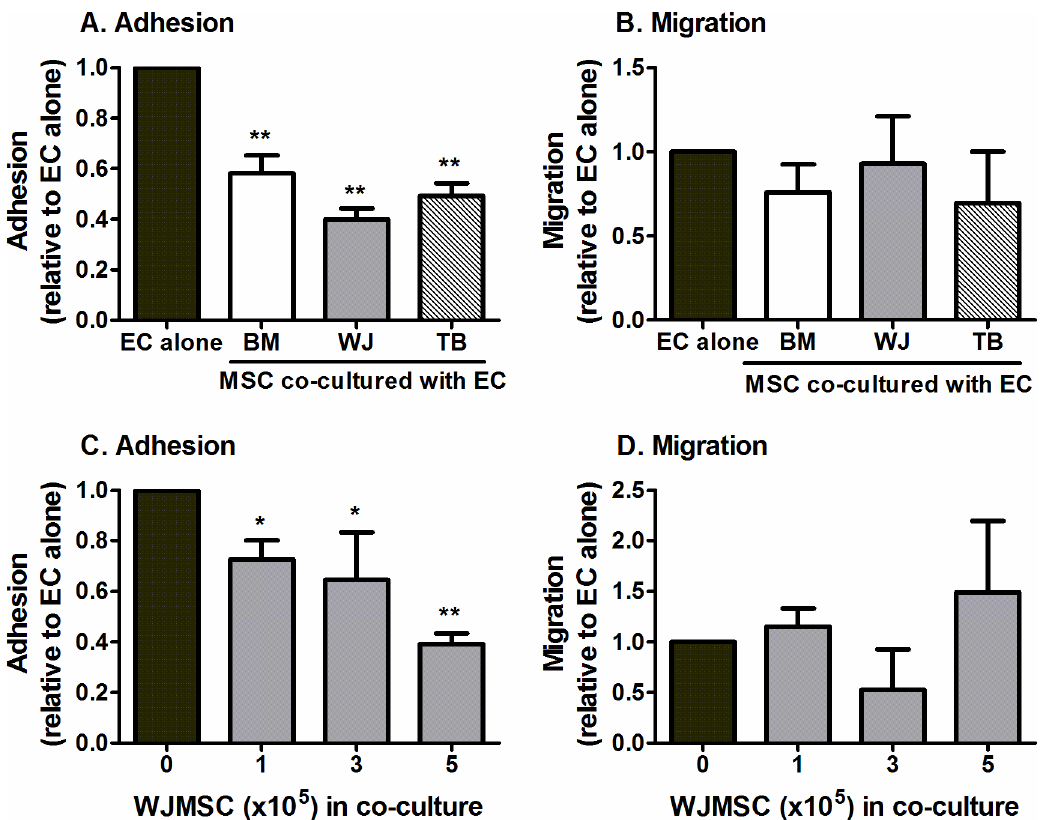
Fig 3. Effect of MSC from different tissues on neutrophil recruitment when cultured on the opposite side of the filter to EC. MSC and EC were cultured on opposite sides of 0.4 μ m porous filters for 24h prior to stimulation with 100U/ ml TNF α for 4h. Co-cultures formed with (A-B) MSC from different sources (BM, WJ, TB) or (C-D) with different numbers of WJMSC. Neutrophil (A,C) adhesion and (B,D) migration were expressed as a proportion of values observed on the paired EC mono-culture control. In A and C, ANOVA showed a significant effect of culture conditions on neutrophil adhesion, p < 0.001. Data are mean ± SEM from (A-B) n = 11 – 13 and (C-D) n = 3 – 5 experiments incorporating a different EC and neutrophil donor in each. (A-B) 3 different BMMSC, 5 different WJMSC and 5 different TBMSC donors were used and (C-D) 5 different WJMSC donors were used, with the exception of 3x10 5 cells where 3 different donors were used * = p < 0.05 and ** = p < 0.01 compared to EC mono-cultures by Dunnett